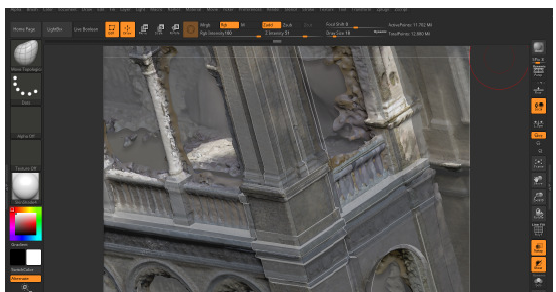
Figure 7. Remodeling process of the semantic elements using zbrush